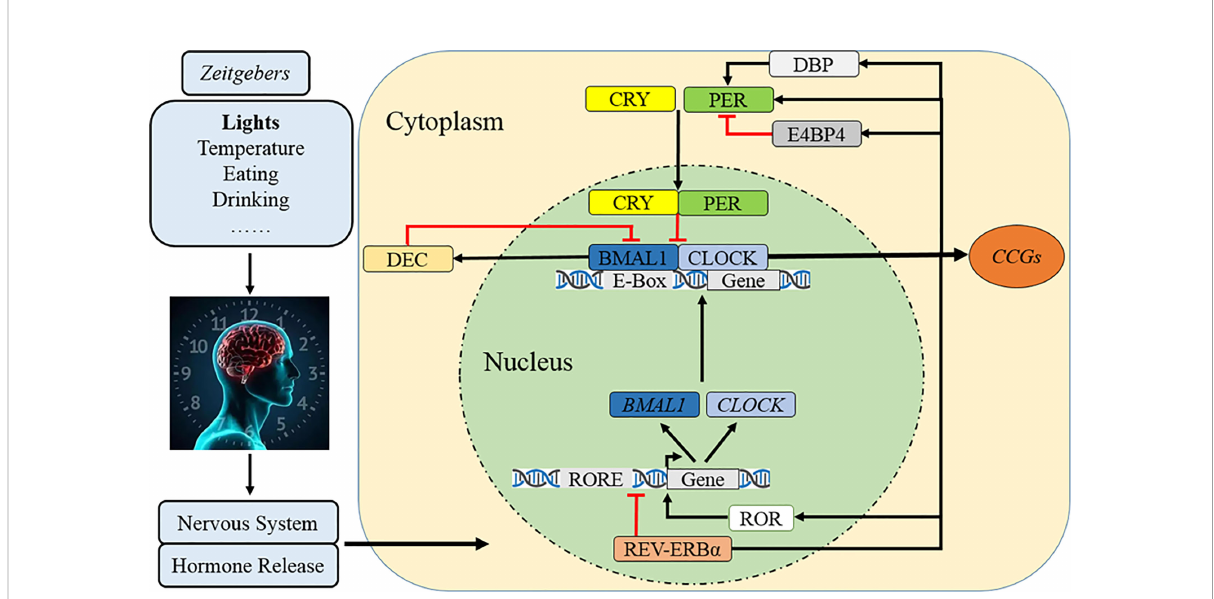
FIGURE 1 Molecular mechanism of the circadian clock. After cues from Zeitgebers are transmitted to SCN as electrical signals, the circadian clock rhythm is orchestrated by a set of genes and proteins which forms interlocked positive and negative feedback loops. Speci fi cally, CLOCK and BMAL1 constitute the core positive heterodimer complex (CLOCK/BMAL1) to activity rhythmic transcription of PER1/2/3 , CRY1/2 , and relevant clock controlled genes ( CCGs ). The repressors of PER and CRY accumulate and form a negative feedback loop in cytoplasm during the day and then translocate back to the nucleus to inhibit the level and activity of CLOCK/BMAL1. The complex of PER/CRY is also subsequently disassembled or resolved, while a new circadian cycle is also followed by another 24 – h. Meanwhile, REV-ERB a reduces BAML1 transcription and ROR a promotes it to manipulate the CLOCK/BMAL1 complex. The third loop involves that DBP induces PER transcription and lengthens the rhythmic period but E4BP4 exerts opposite effects, while DEC inhibits CLOCK/BMAL1-induced PER1